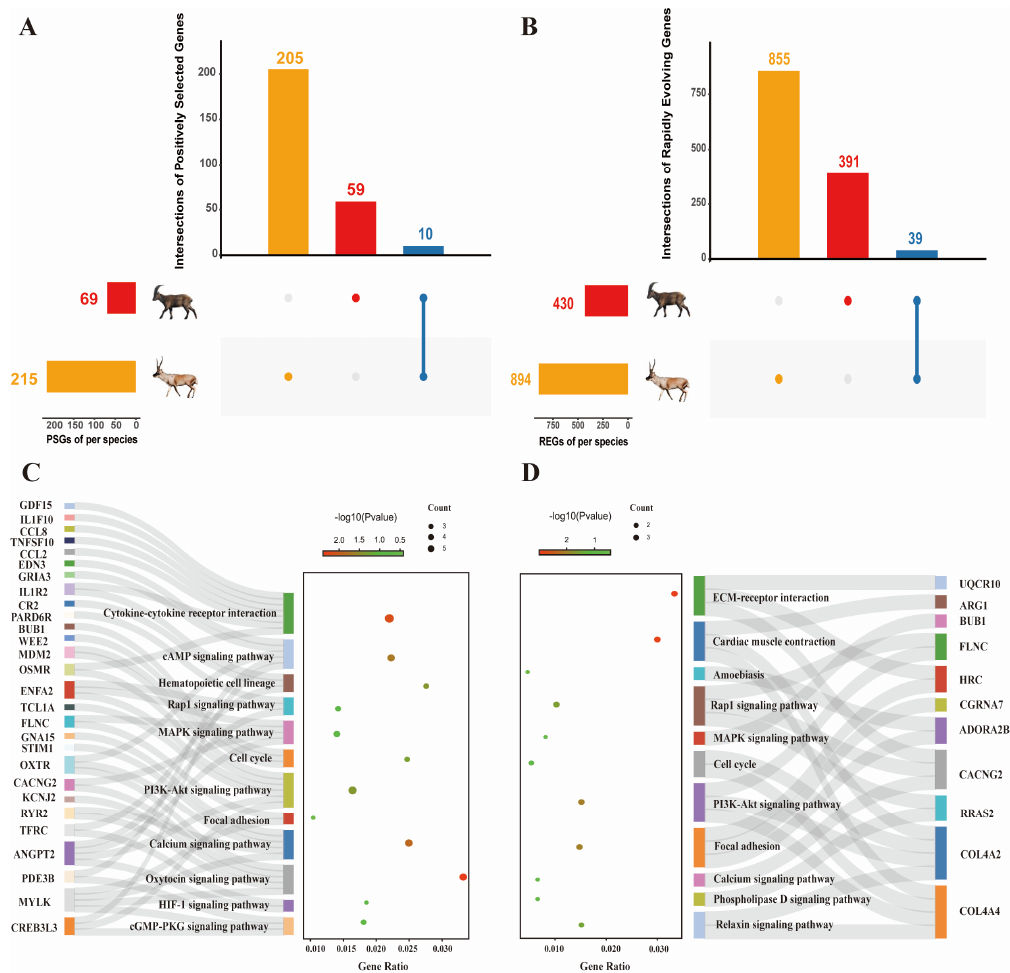
Figure 2. Analysis of positively selected genes and rapidly evolving genes between Tibetan antelope and Siberian ibex. ( A ) The number and overlap of PSGs in Tibetan antelope and Siberian ibex. ( B ) The number and overlap of REGs in Tibetan antelope and Siberian ibex. Orange column represents the uniqueness of Tibetan antelope, red column represents the uniqueness of Siberian ibex, blue column represents the commonality between the two species. ( C ) The KEGG pathway enrichment analysis of PSGs in Tibetan antelope. ( D ) The KEGG pathway enrichment analysis of PSGs in Siberian ibex.